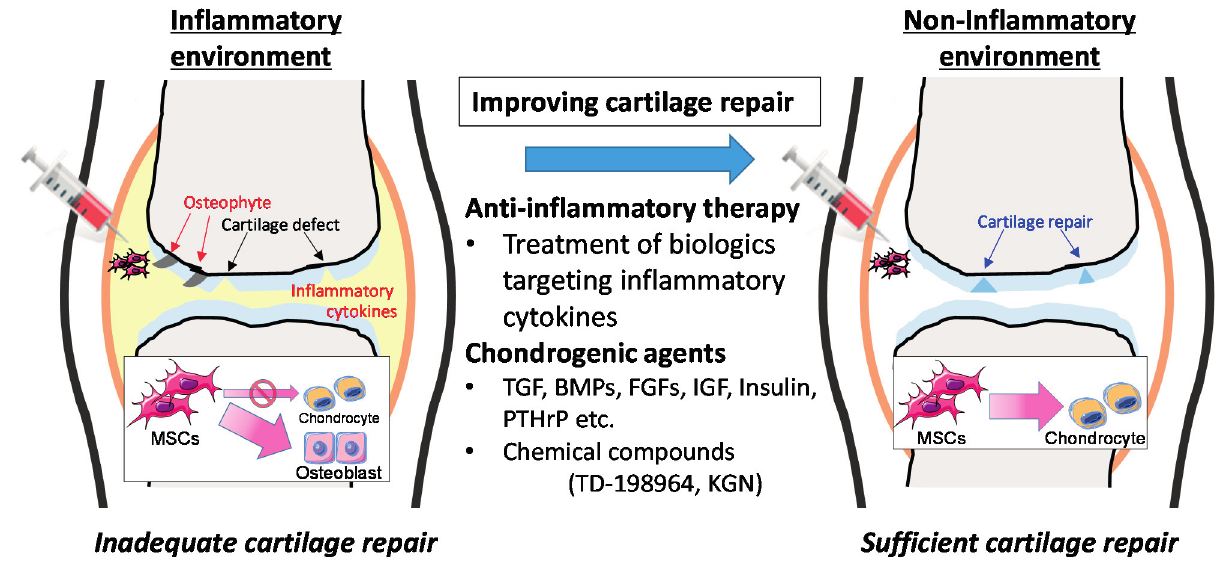
Figure 2. Strategies for efficient cartilage repair therapy by intra-articular injection of mesenchymal stem cells (MSCs). The inflammatory environment is present in the joints affected by rheumatoid arthritis (RA) or osteoarthritis (OA). Chondrogenic differentiation of intra-articular injected MSCs is inefficient under inflammatory conditions. Therefore, preoperative treatment with anti-inflammatory drugs and/or chondrogenic agents should be important for efficient cartilage repair